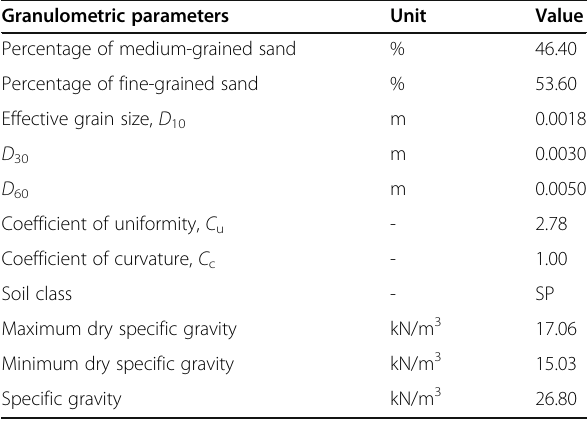
Table 1 Soil sample physical properties